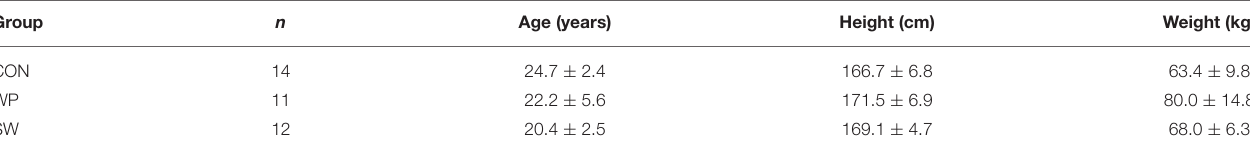
TABLE 1 | Participant characteristics. Group